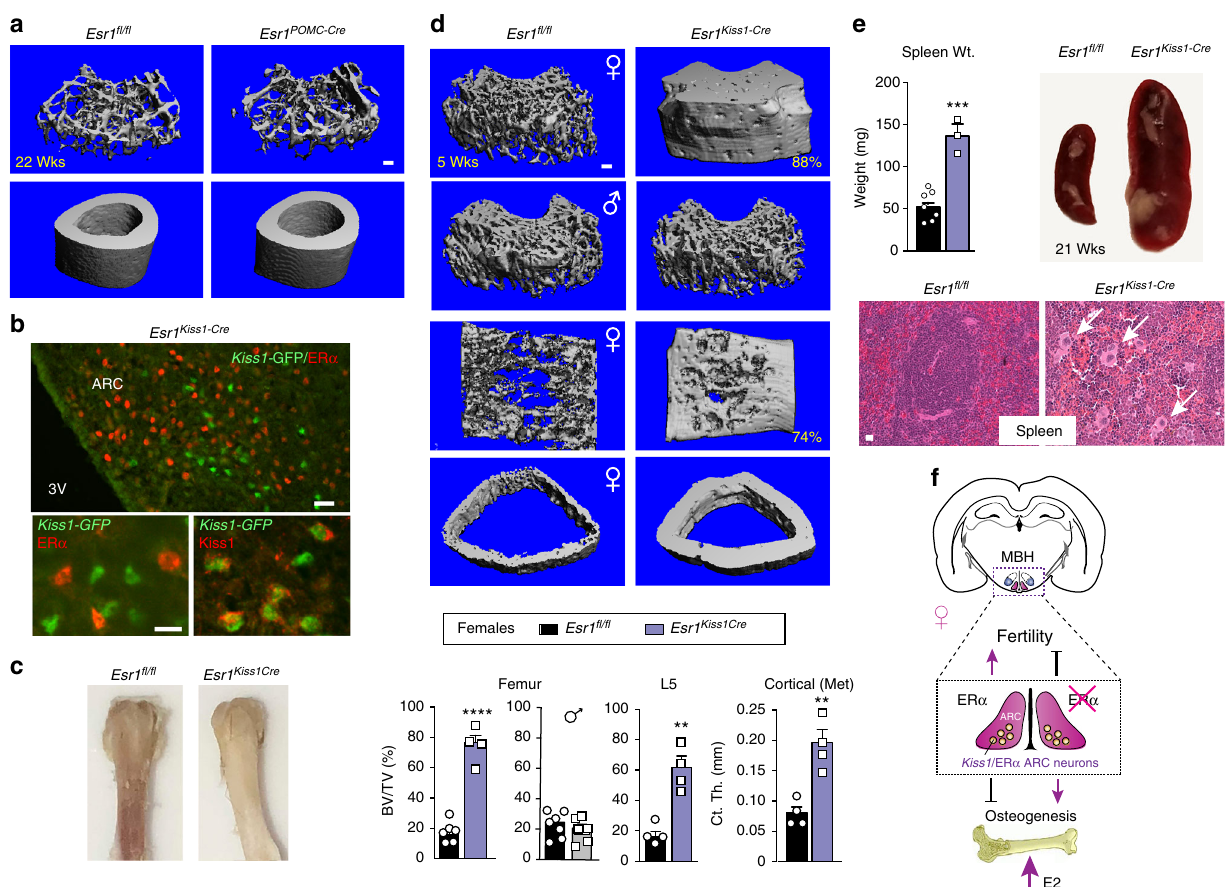
Fig. 6 Deletion of ER α in Kiss1 neurons elicits an increase in bone mass. a Representative μ CT images of femoral and cortical bone for Esr1 fl / fl ( n = 3) and Esr1 PomcCre ( n = 3) at 22 weeks of age. b Representative images demonstrating loss of ER α (red) in Cre-GFP-expressing Kiss1 neurons stained for either GFP (green) or KISS1 (red) in the female ARC. Scale bars = 25 µ m (top panel) and 10 µ m (bottom panels). c Photograph of Esr1 fl / fl and Esr1 KissCre female femurs at 6 weeks of age. d μ CT images of the distal femur, L5 vertebrae and cross section of cortical bone at metaphysis in Esr1 fl / fl (black) control and Esr1 KissCre mutant females (purple) as well as the distal femur from males (grey, 4.5 weeks). %BV/TV for female distal femur controls ( n = 6) and mutants ( n = 4), for L5 controls ( n = 4) and mutants ( n = 4), and the cortical thickness at metaphysis for controls ( n = 4) and mutants ( n = 4). %BV/TV for male distal femur controls ( n = 7) and mutants ( n = 6) males. e Spleen weights of younger (4 – 12 weeks) Esr1 fl / fl ( n = 7) and Esr1 KissCre ( n = 3) and images of spleen from a control and a mutant female at 21 weeks of age. Representative images of (20×) H&E stained spleens from control and mutant females at 21 weeks. White arrows point to megakaryocytes. f Schematic showing the positive and negative roles of central estrogen signaling in ARC Kiss1 neurons on fertility and bone, respectively. Error bars are ±SEM. Unpaired Student ’ s t test ( d , e ). ** p < 0.01; *** p < 0.001; **** p < 0.0001. Scale bars = 100 μ